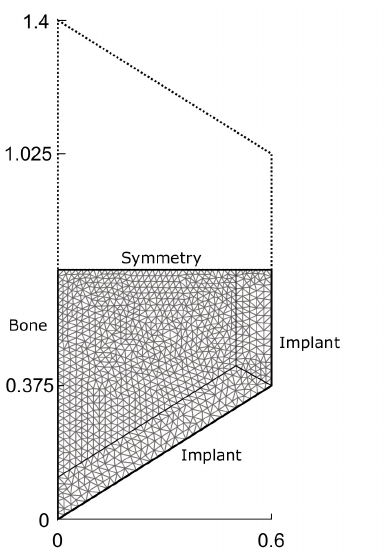
Figure 7. Computational domain and mesh for the two-dimensional problem. Due to the symmetry of the problem, only half of the domain was simulated. Interior borders were added to ensure that at the regions of discontinuity for the derivatives of p , only edges were placed. Dimensions in mm.